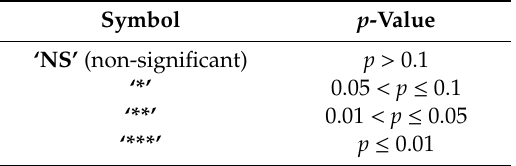
Table 1. Intervals for determination of p -Value for the F-test.